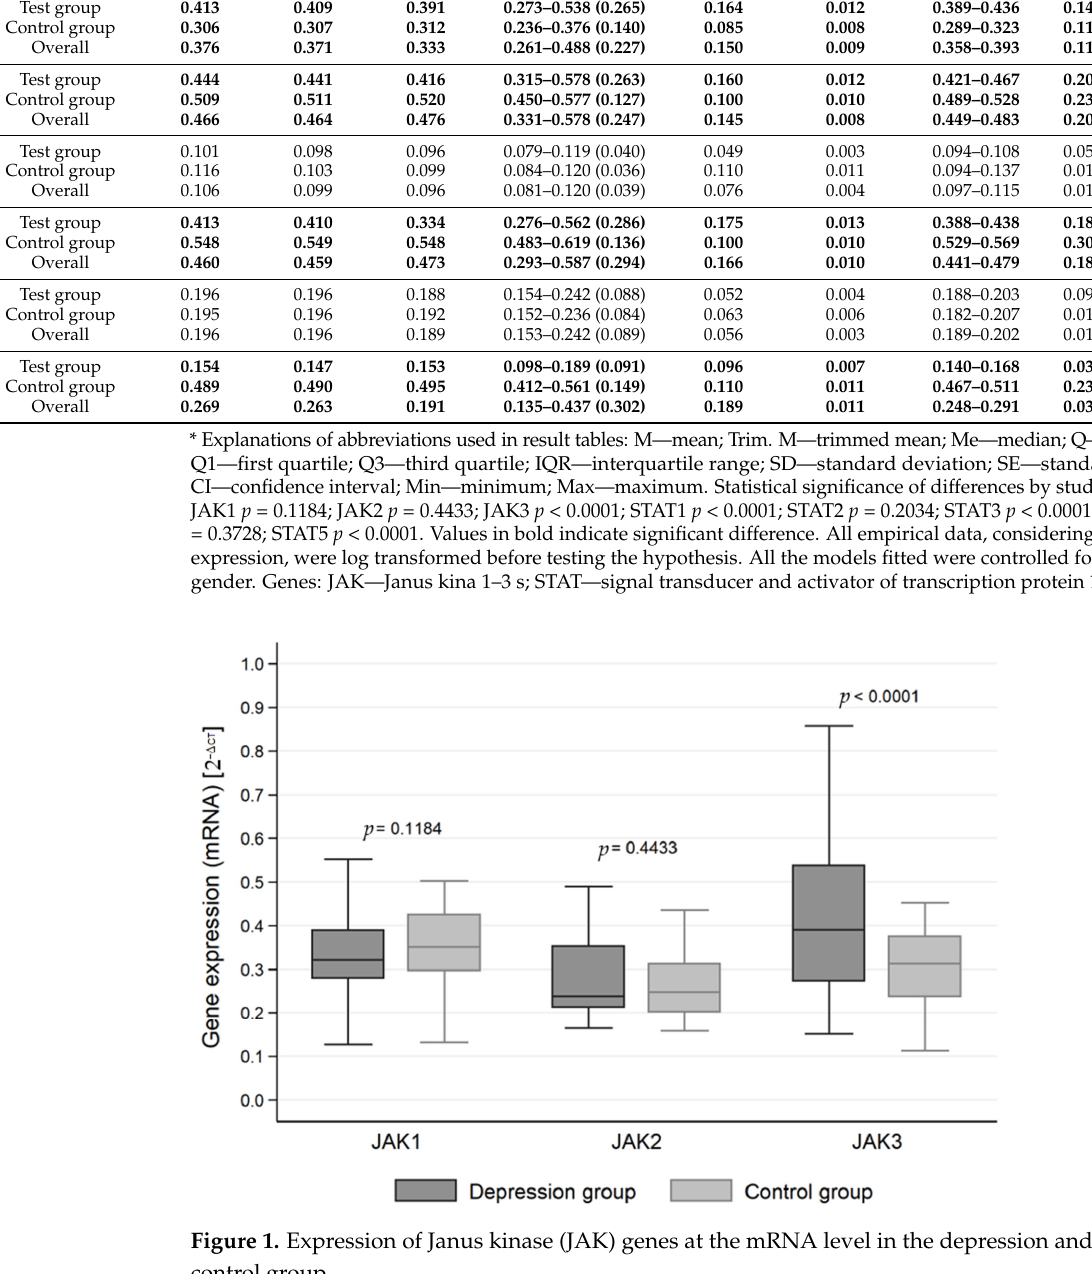
Figure 2. Expression of signal transducer and activator of transcription (STAT) protein family genes at the mRNA level in the depression and healthy control group. 3.2. Mean Protein Expression The expression of genes at the protein level in the studied groups differed statistically significantly in the case of JAK3 ( p < 0.0001), STAT1 ( p = 0.0120), STAT2 ( p < 0.0001), STAT3 ( p < 0.0001) and STAT4 ( p < 0.001). JAK3 and STAT4 gene expression at the protein level was statistically significantly higher in the study group than in the control group (1.547 vs. 1.156 and 0.640 vs. 0.175, respectively). In turn, protein expression for STAT1, STAT2